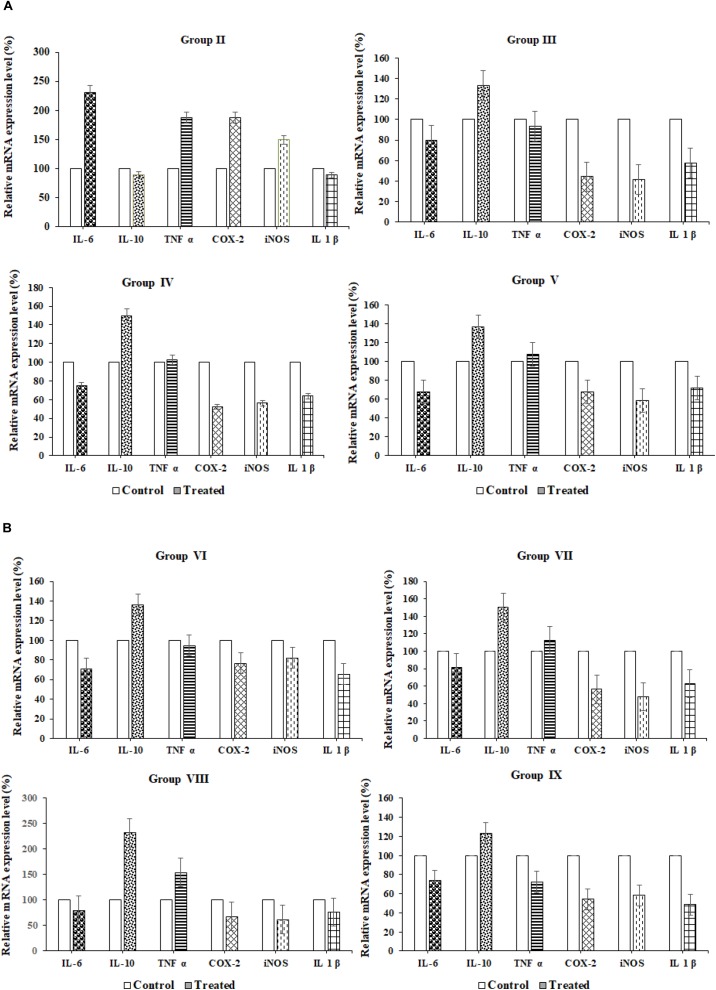
(A) qRT-PCR. (B) qRT-PCR.